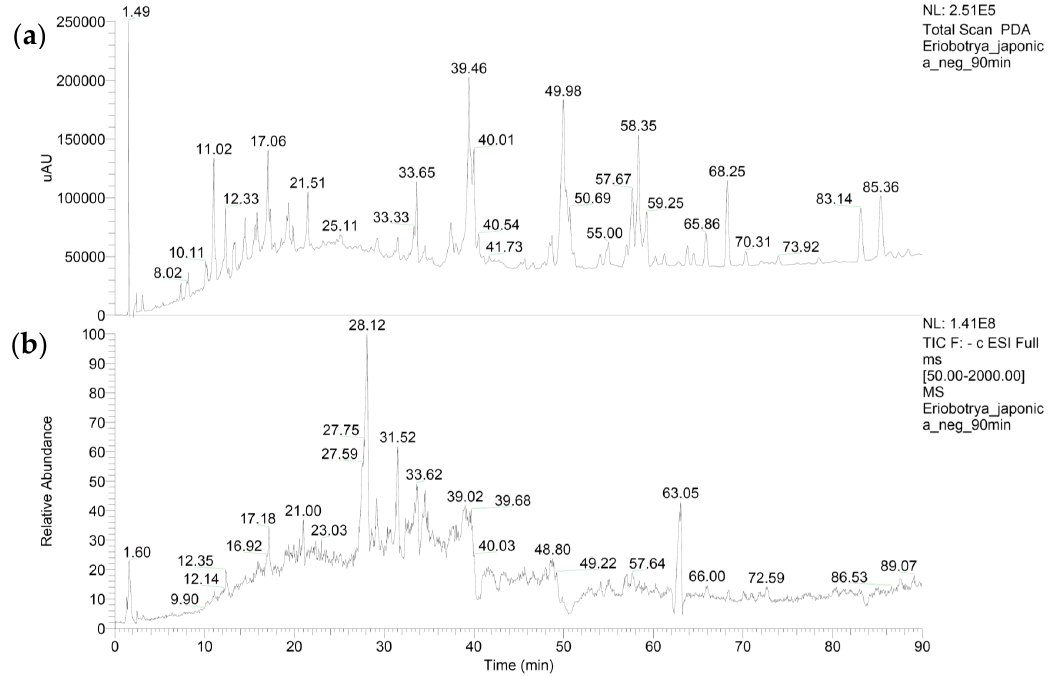
Figure 3. The photodiode array chromatogram (PDA) ( a ) and the total ion current (TIC) ( b ) of the E. japonica . The compounds listed in Table 3 correspond to the retention times of the TIC. Table 3. Retention times (RT), MS data, and tentatively identified compounds in the E.japonica extract.